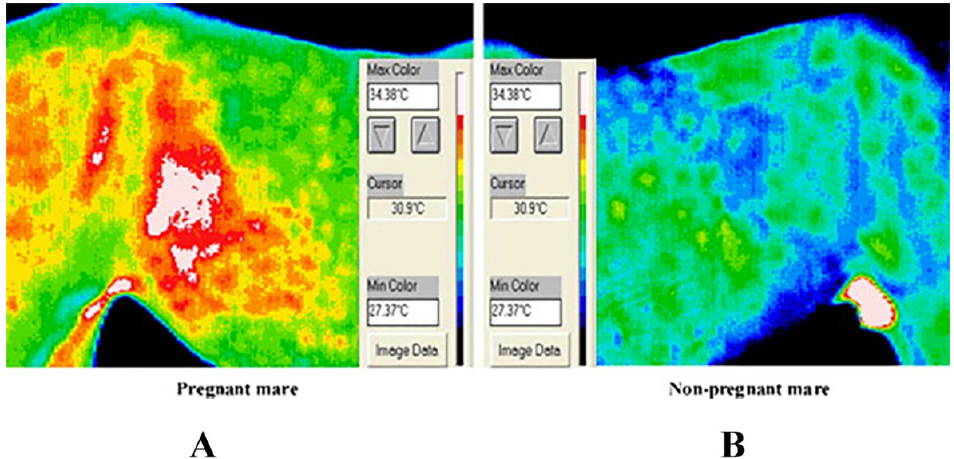
Figure 5. IRT imaging technology in pregnancy diagnosis of animals. ( A ), Infrared image of a pregnant mare. ( B ), Infrared image of a nonpregnant mare. The pregnant mare has a higher flank/abdomen temperature than the nonpregnant mare. Reprinted with permission from Ref. [50]. Copyright Elsevier and copyright clearance center.